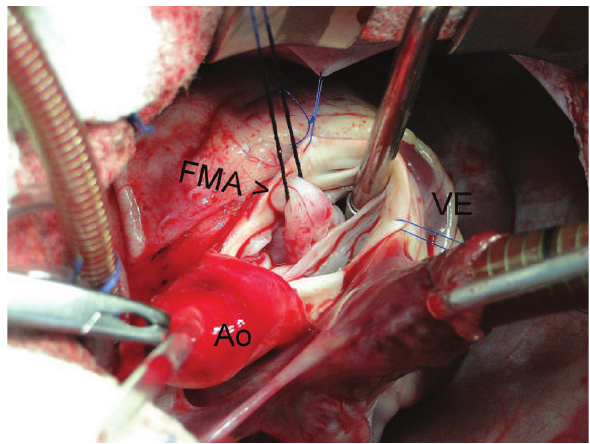
Fig. 1. Ecocardiograma bidimensional em corte paraesternal longitudinal, demonstrando o abaulamento sistólico do folheto mitral acessório (setas), obstruindo a via de saída do ventrículo esquerdo. AE = átrio esquerdo, VE = ventrículo esquerdo, VD = ventrículo direito